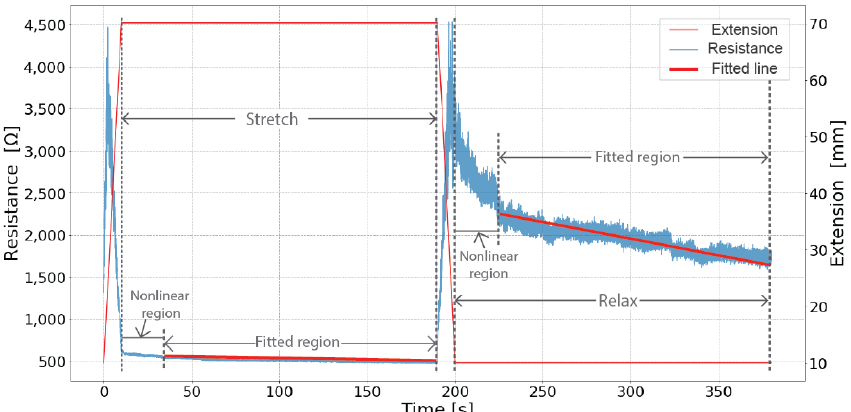
Figure 5. An example of linearity fitting a static test with Sample 9. The linear region is fit with a line when the sample is held in a stretched and relaxed